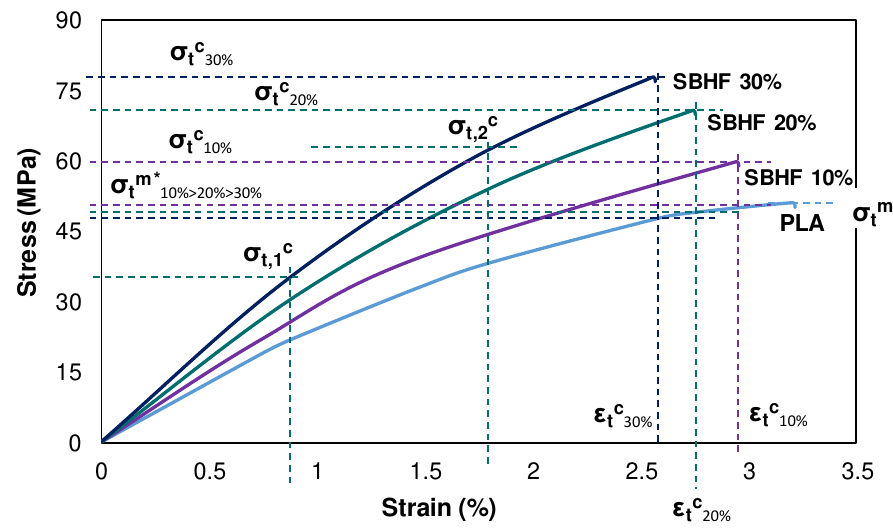
Figure 2. Mean stress–strain curves of PLA/SBHF composites, indicating the strength of the matrix at composite fracture in each case. Percentages are based on weight. Table 2. Tensile strength and relative enhancements over the PLA matrix that were attained by PLA/SBHF, in comparison to PLA/untreated hemp, PLA/GF, and PP/GF. The elongation and the volume fraction are also reported.